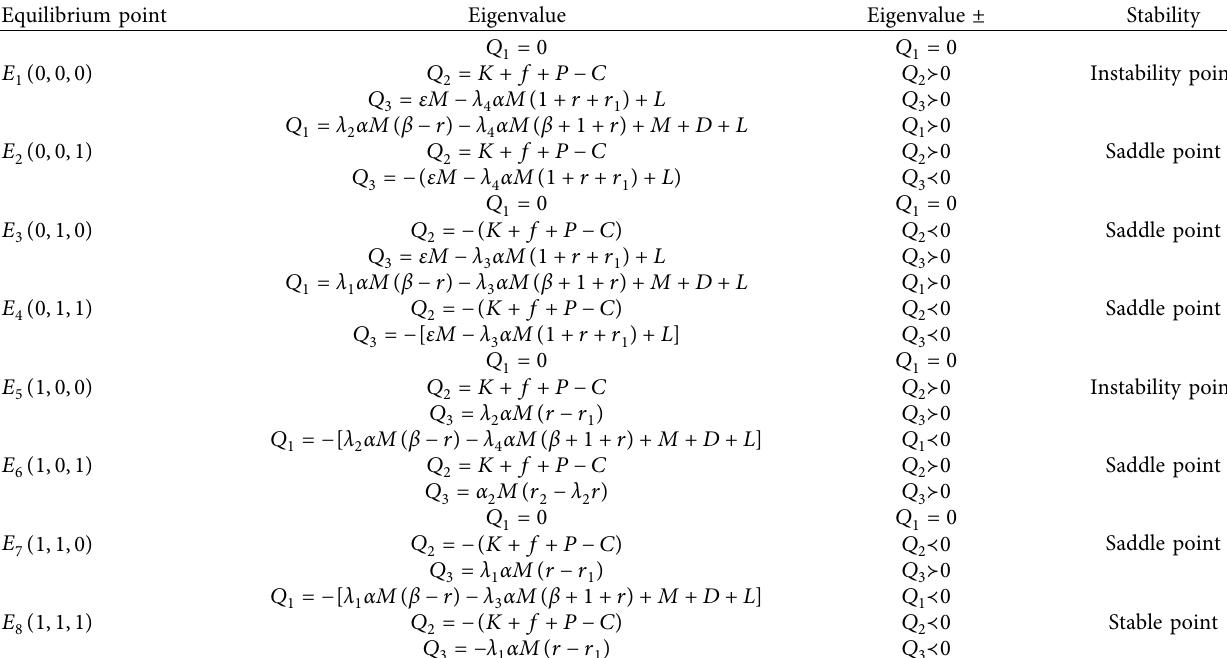
Table 4: Stability analysis of equalization